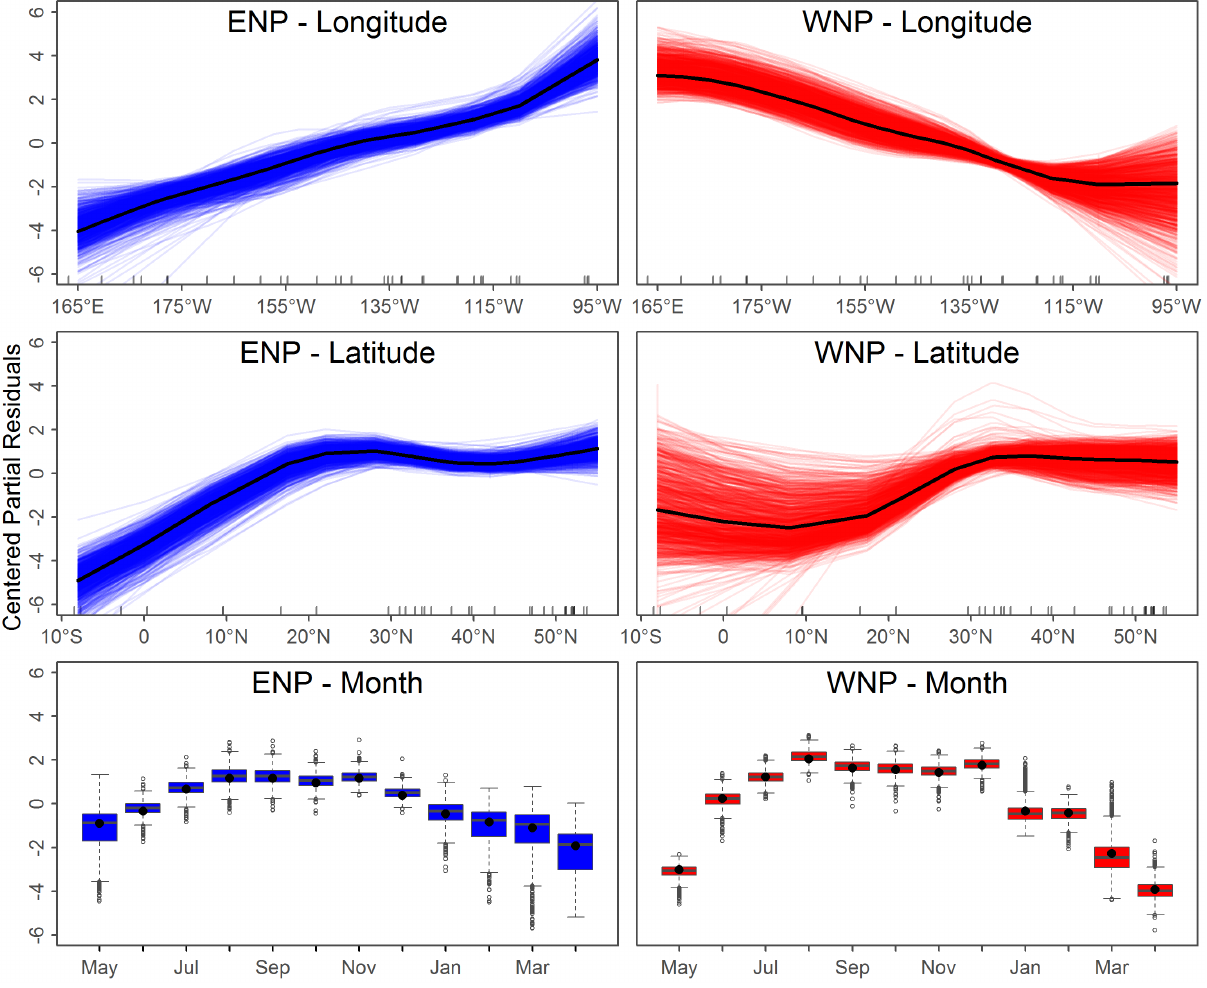
Figure 8. Fits of the independent variables for the probability of observing a song call ( p parameter). The original model (black lines) and subsequent bootstrapped models (thin colored lines) are shown. Each panel shows the relationship between the dependent and independent variable after all other independent variables have been accounted for (i.e. the centered partial residuals). Higher relative values indicate a higher probability of observing a call. For longitude and latitude, x -axis tick marks show positions of the observed hydrophones with a small amount of noise added to prevent overplotting. See text for further discussion.